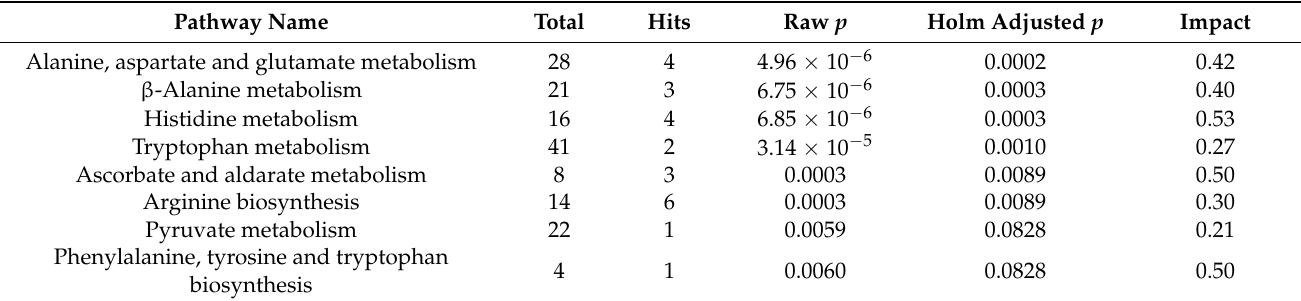
Table 4. Metabolic pathways of differential